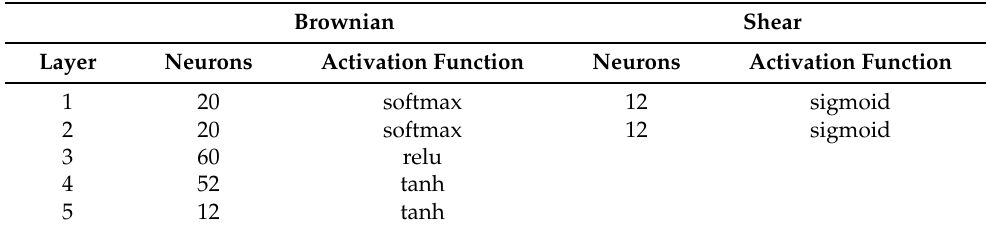
Table 3. Configurations of the obtained ANN